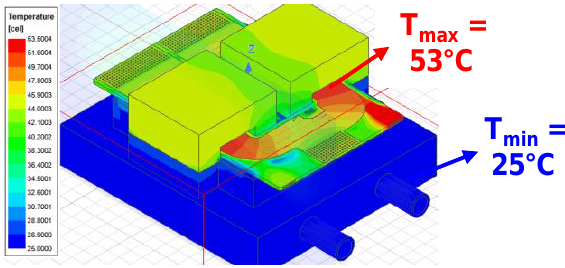
Figure 11. Temperature rise according to the conduction loss of PCB winding at 270 V input and 100% load conditions.